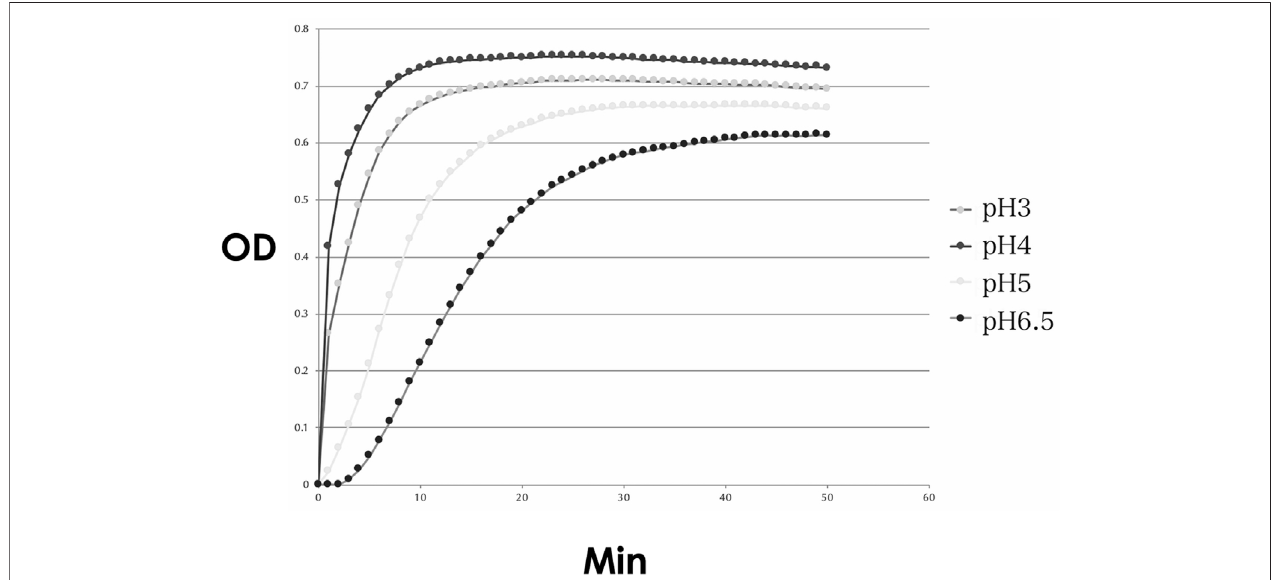
FIGURE 12 | Urease activity of the cultured NHPH. Urease activity was found to be strongest at pH 4, followed by pH 3, and became weak at pH 5 and 6.5. OD: optical density.